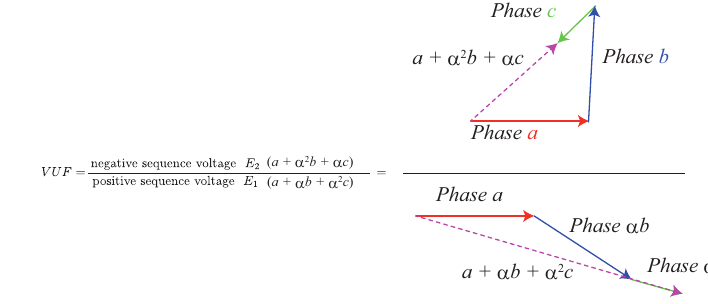
Figure 5. A graphical interpretation of VUF in an unbalanced